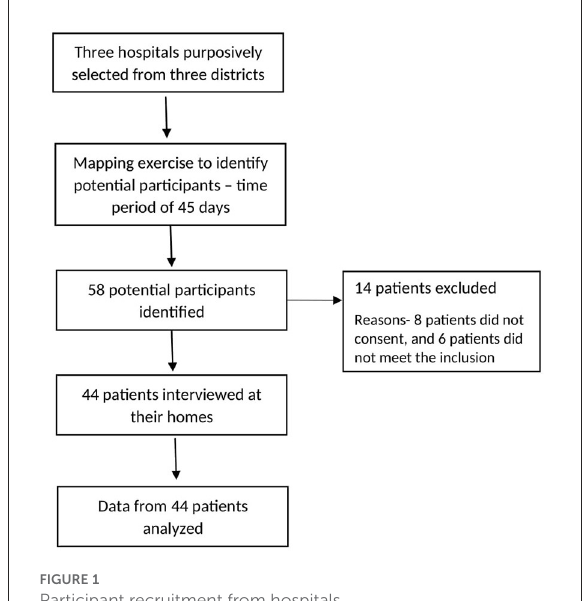
FIGURE1 Participant recruitment from